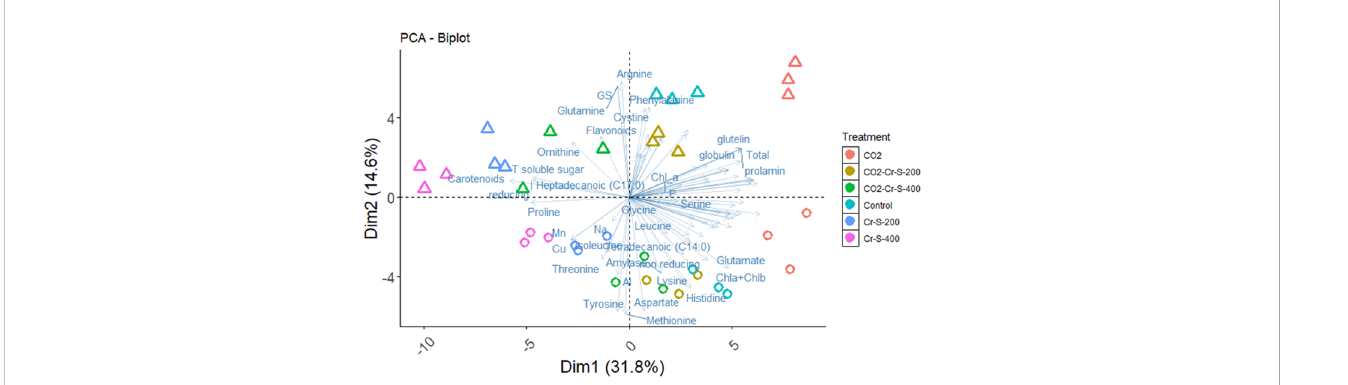
FIGURE 5 Principal component analysis (PCA) of biochemical parameters of rice grains produced under Chromium (Cr) and either aCO2 (410 ppm) or eCO2 (620 ppm). Variances explained by the fi rst two components (PC1 and PC2) appear in parentheses.